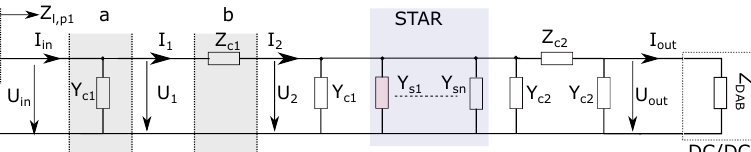
Figure 18. Equivalent model of the star connected offshore DC grid as seen from point P 1 .